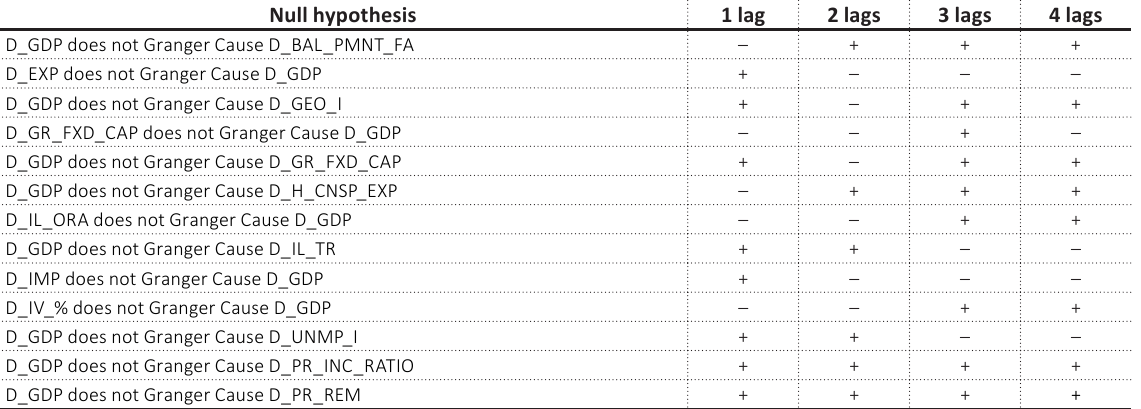
Table 3. Causal relationships between time series Null hypothesis 1 lag 2 lags 3 lags 4 lags